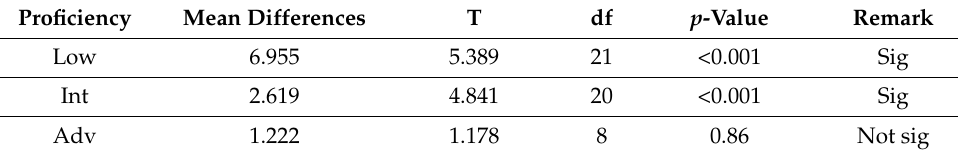
Table 9. Statistical results from paired samples t -tests for L3